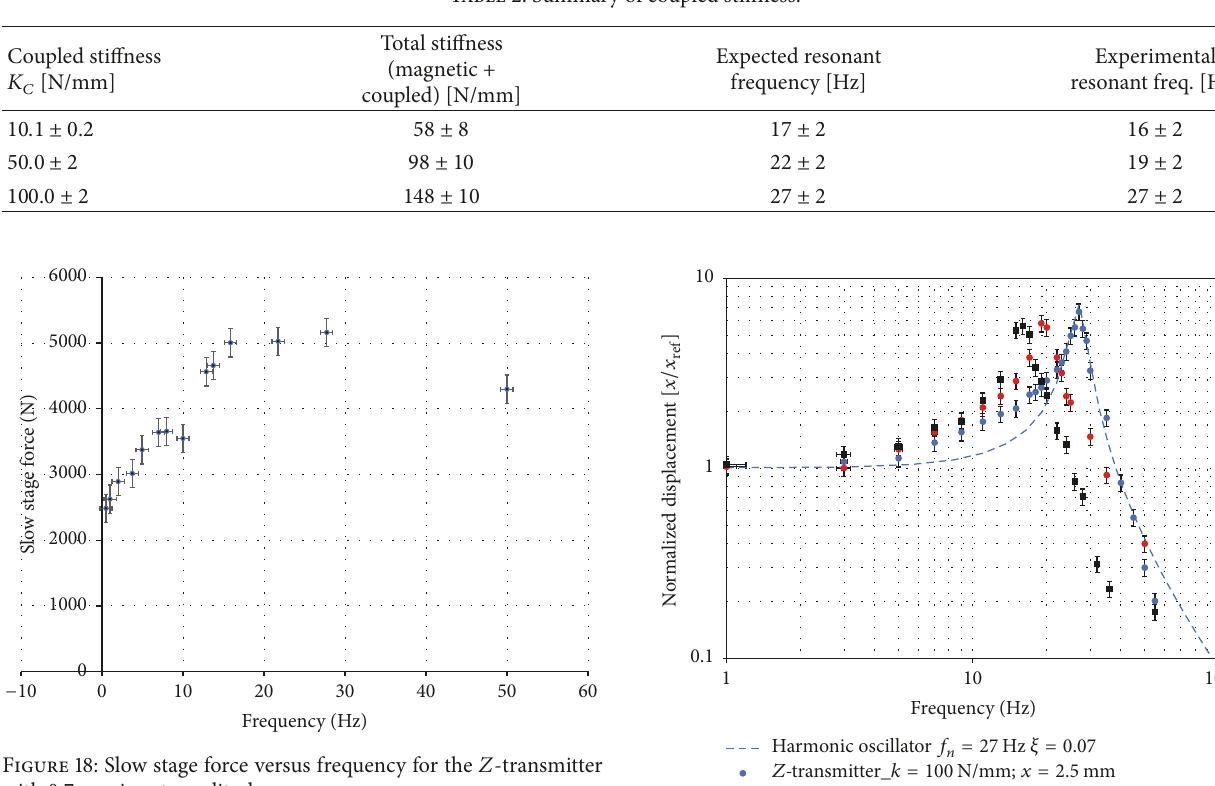
Table 2: Summary of coupled stiffness.